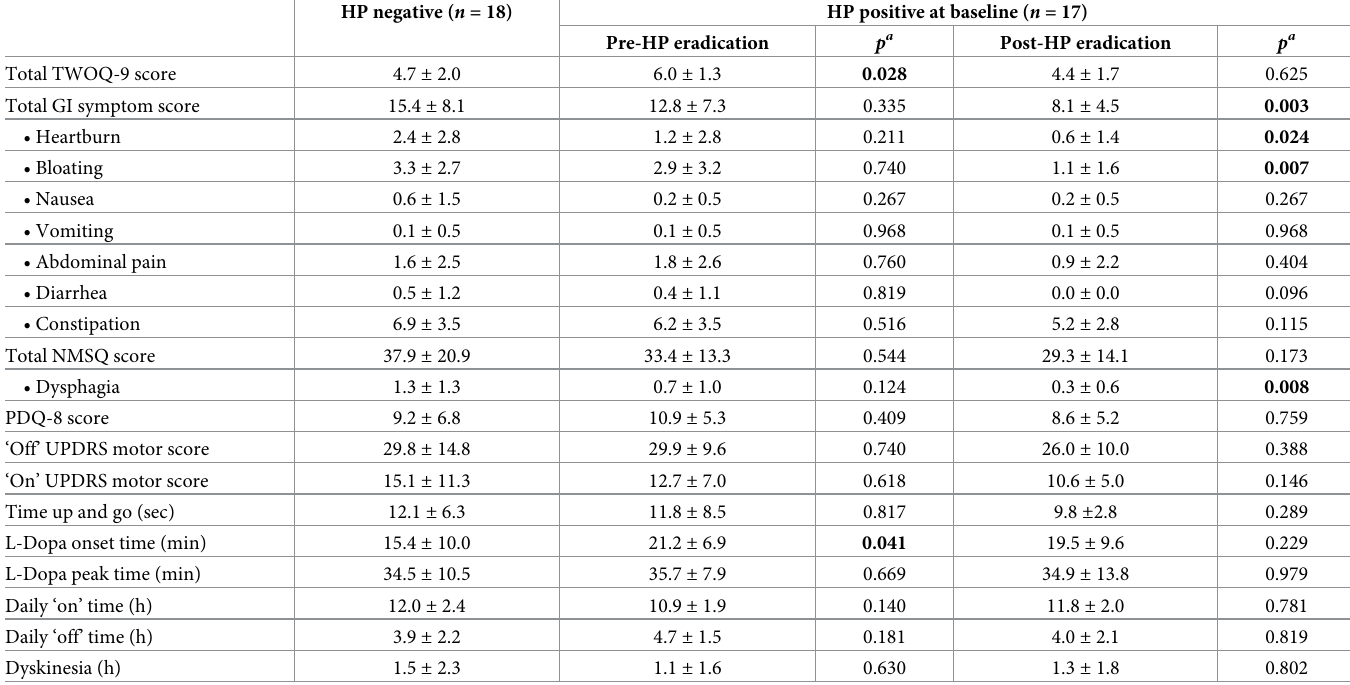
Table 4. Clinical symptoms between patients with Helicobacter pylori (HP) negative and successful HP eradication